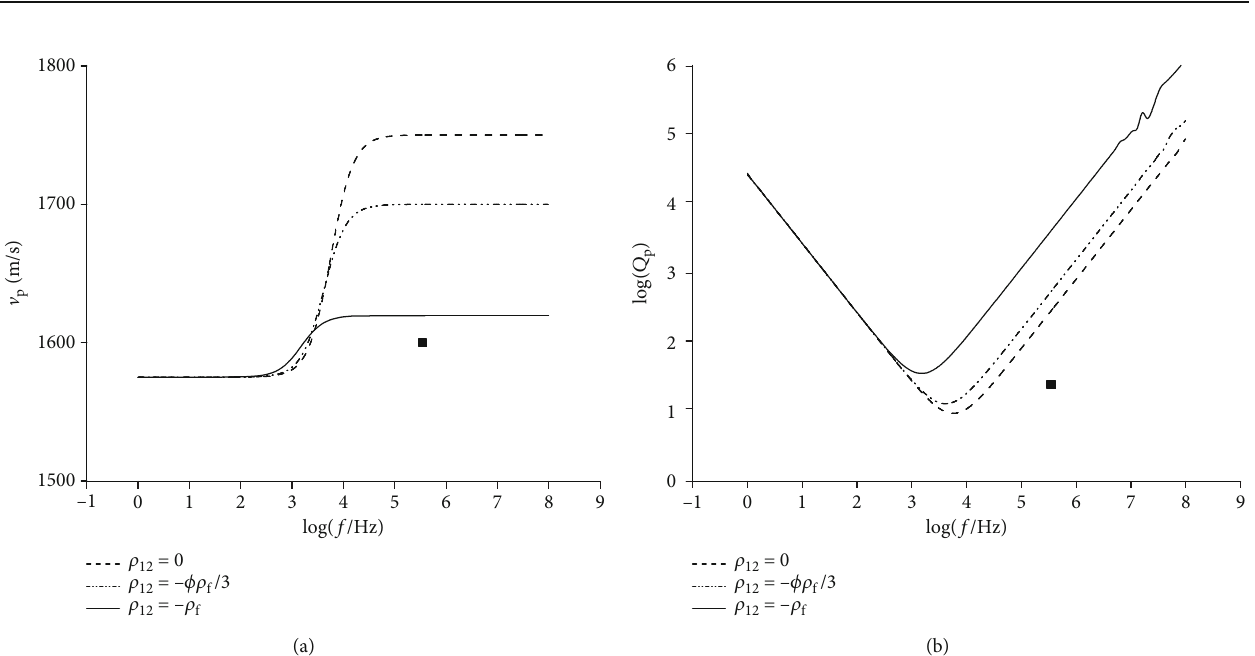
Figure 1: (a) Theoretical velocity ( V p ) of P wave in unconsolidated Toyoura sands predicted by the Biot theory [1] versus measurement represented by square. The left end is corresponding to Gassmann velocity while the right end is corresponding to the velocity in drained sands which does not equal the dry velocity. (b) Theoretical quality factor ( Q p ) versus measurement (in which the minimum Q p will appear at lower frequency with increased value, as coupling factor ρ 12 decreases from zero). Note that Darcy permeability is 23 Darcy.